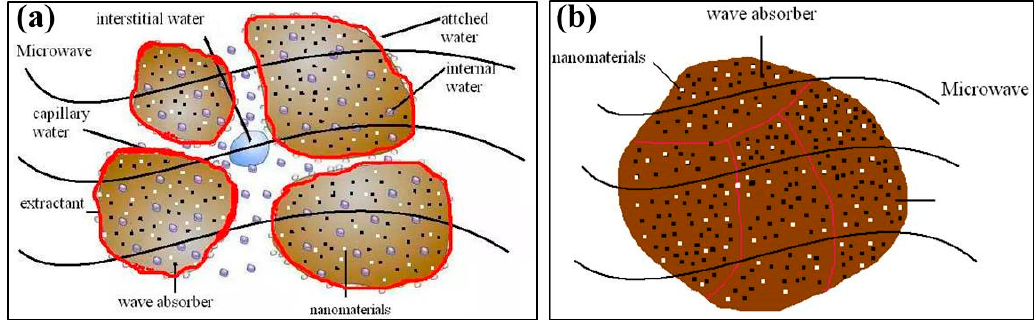
Figure 1. Illustration of sludge mixed with various additives ( a ) and municipal dewatered sludge after microwave treatment ( b ).